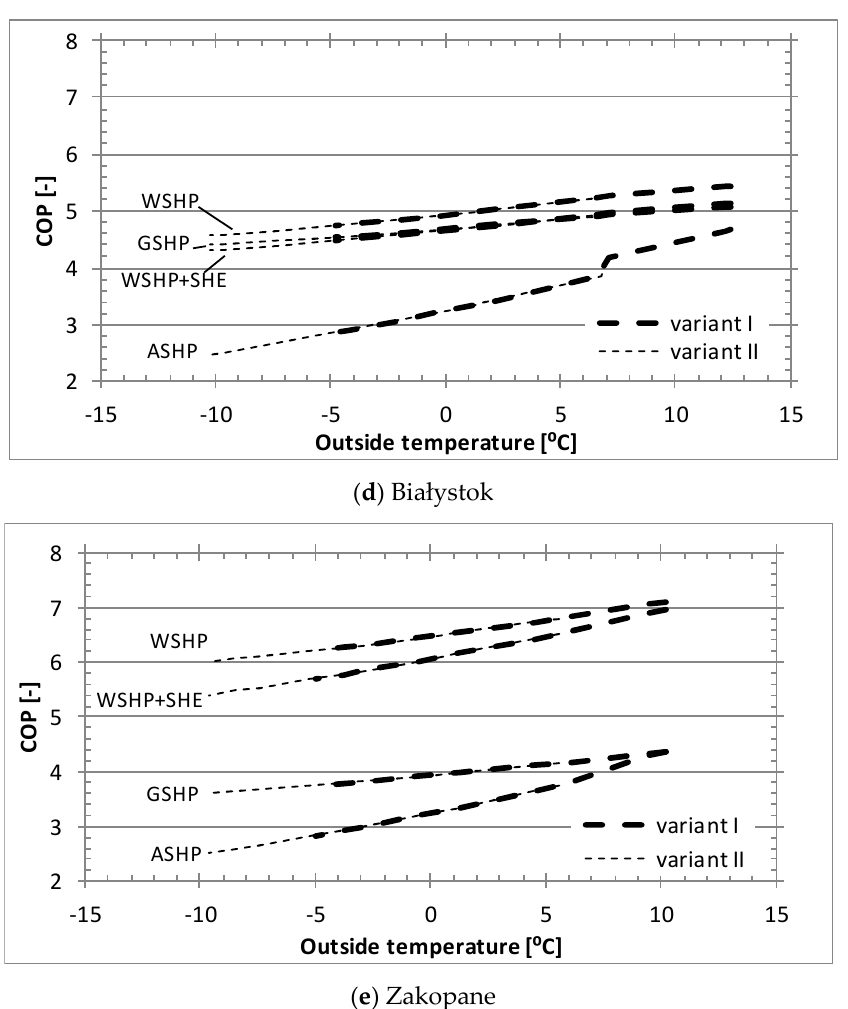
Figure 3. COP bin values depending on the outdoor temperature in each investigated location: ( a ) zone I (Szczecin), ( b ) zone II (Poznań), ( c ) zone III (Łódź), ( d ) zone IV (Białystok), ( e ) zone V (Zakopane).